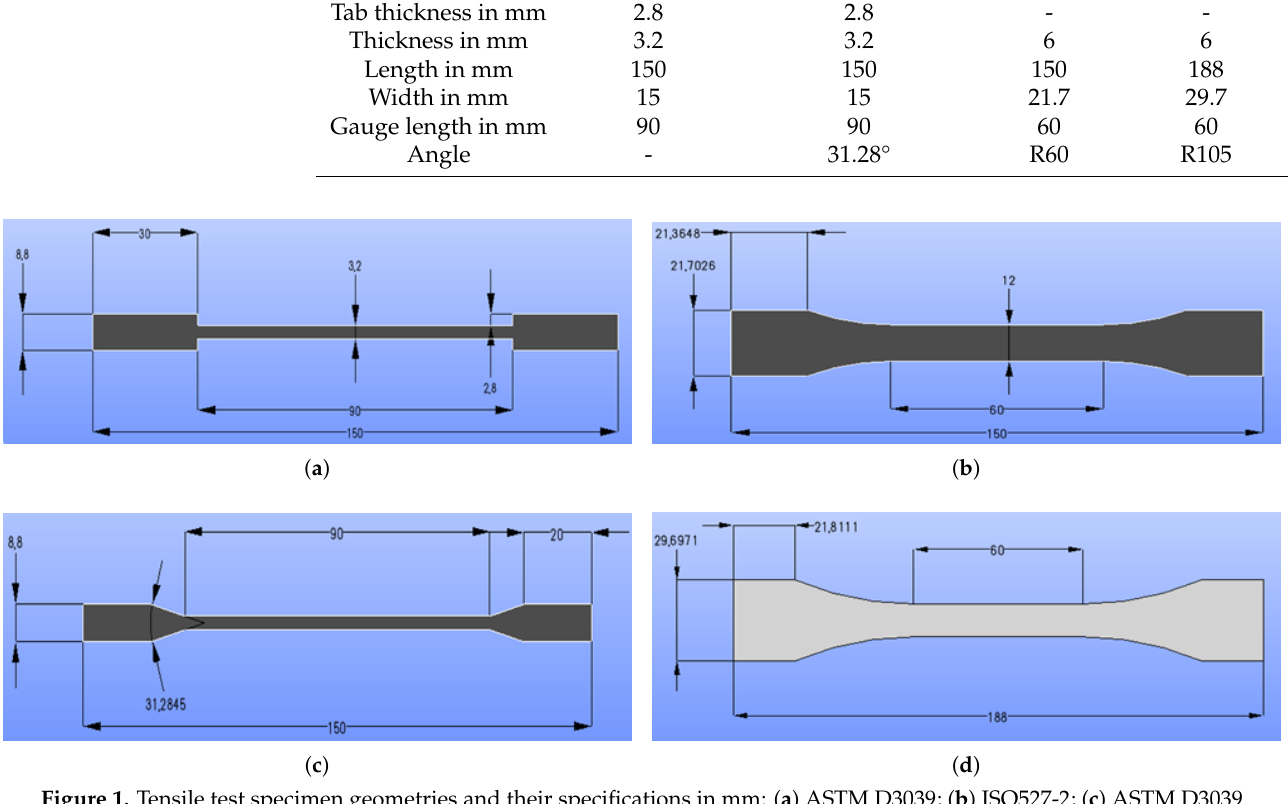
Figure 1. Tensile test specimen geometries and their specifications in mm: ( a ) ASTM D3039; ( b ) ISO527-2; ( c ) ASTM D3039 angle and ( d )